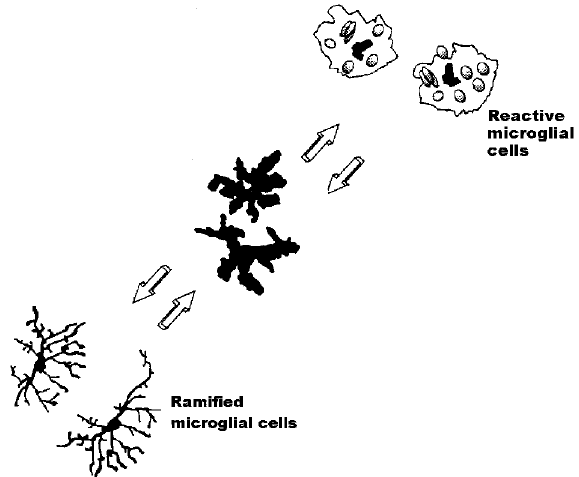
FIG. 1. Microglial cell activation cascade. Schematic drawing illustrating the transition of microglial cells from ramified microglial cells to the ameboid microglial cell, adapted from Ref.